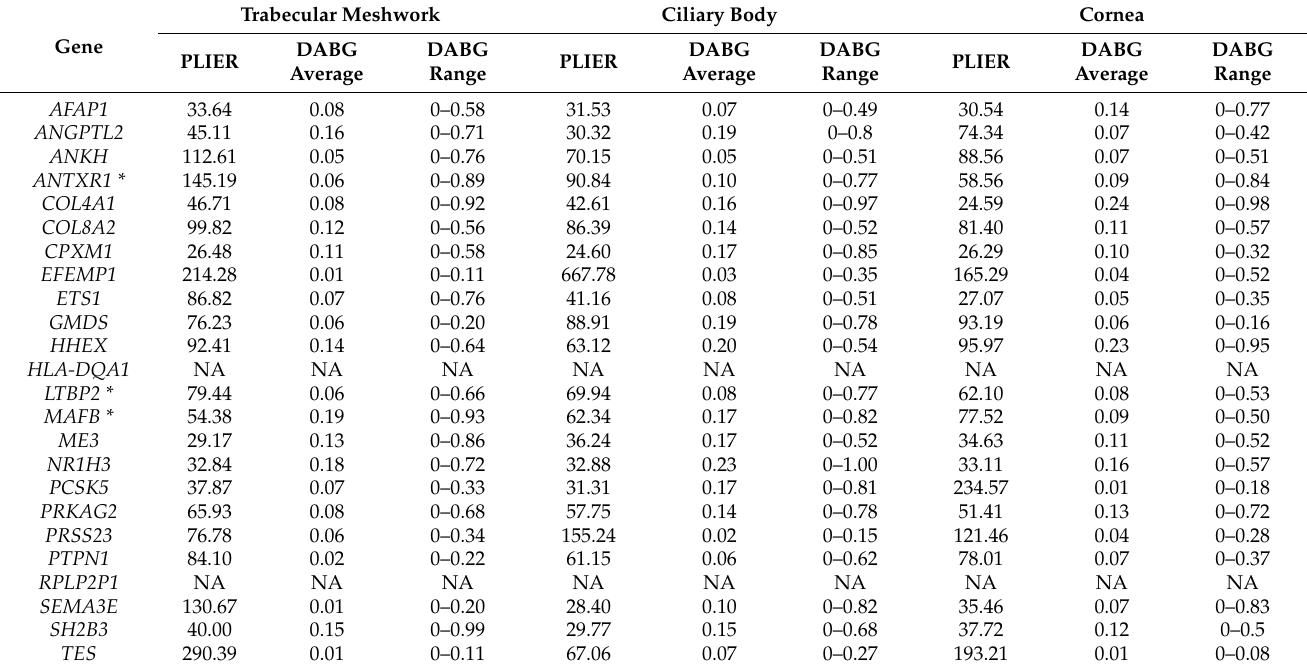
Table 4. Expression of Differentially Expressed Intraocular Pressure-Associated Genes in the Human Ocular Tissue Database.